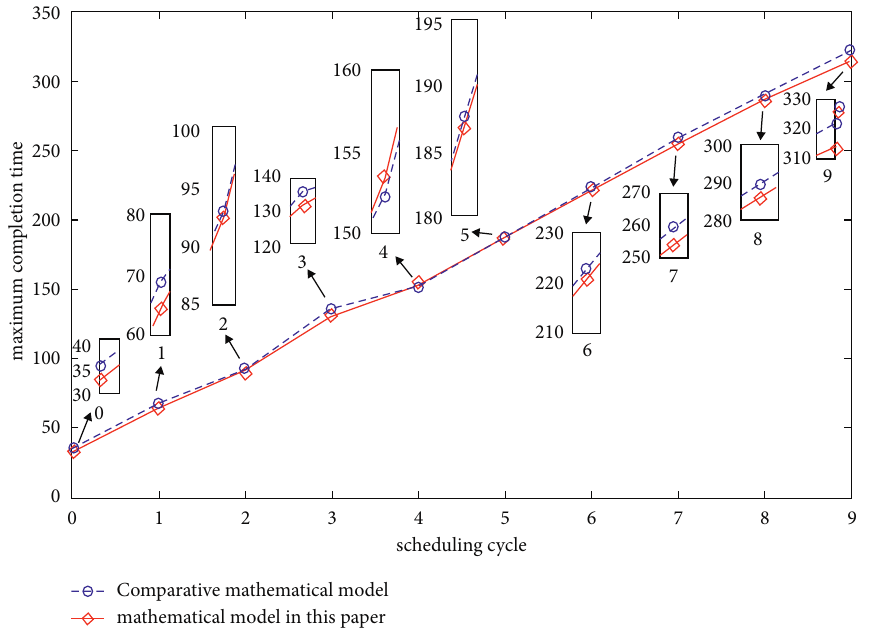
Figure 14: Comparison of the maximum completion time of each scheduling